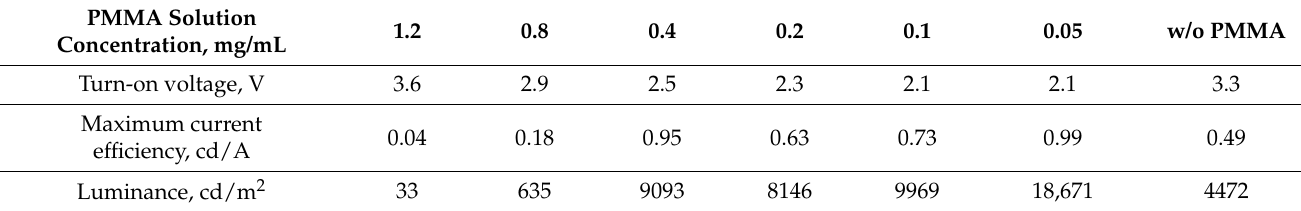
Table 1. Summary of the performance parameters of the fabricated QDLED devices with and without a PMMA layer deposited from PMMA solutions with different